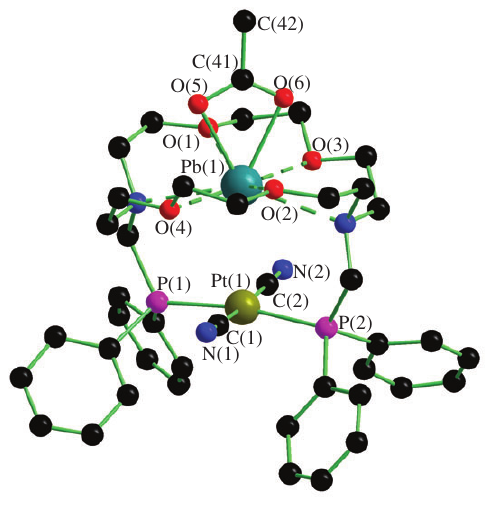
) Pt(Ph SnC(S)SMe) (phenyl groups are 3 2 3